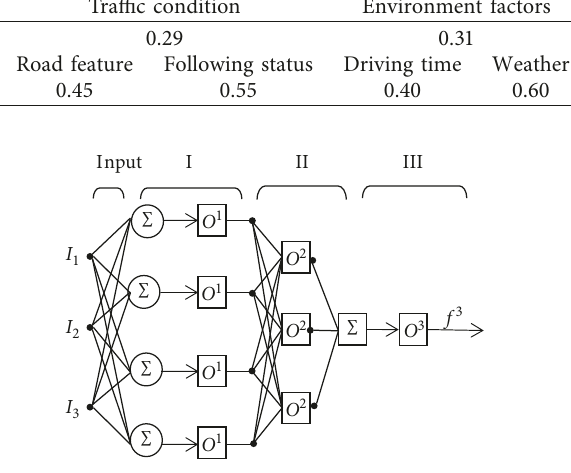
Figure 1: Neural network